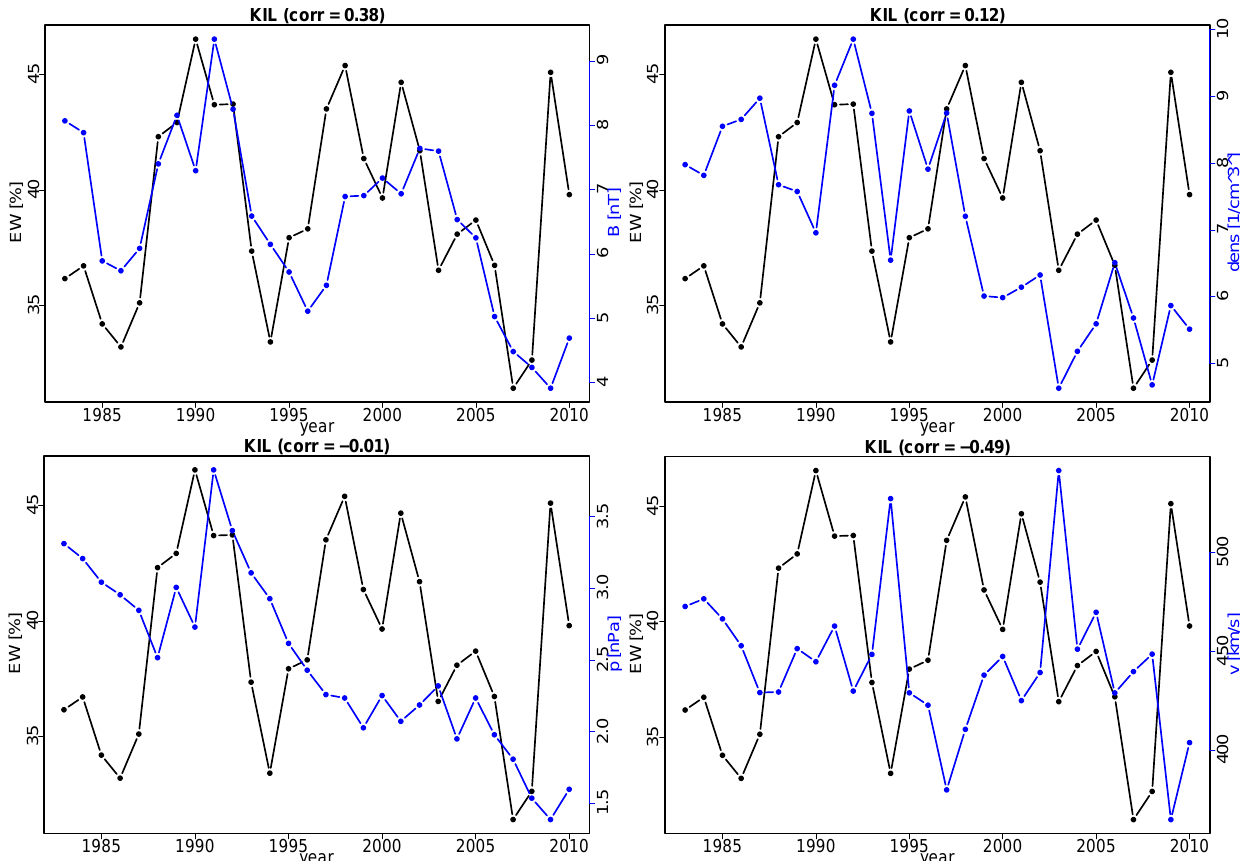
Fig. 6. Yearly fraction of EW directed large d H /dt vectors at KIL (black) and the following solar wind parameters (blue): magnitude of the magnetic field ( B ), density ( dens ), dynamic pressure ( p ), velocity ( v